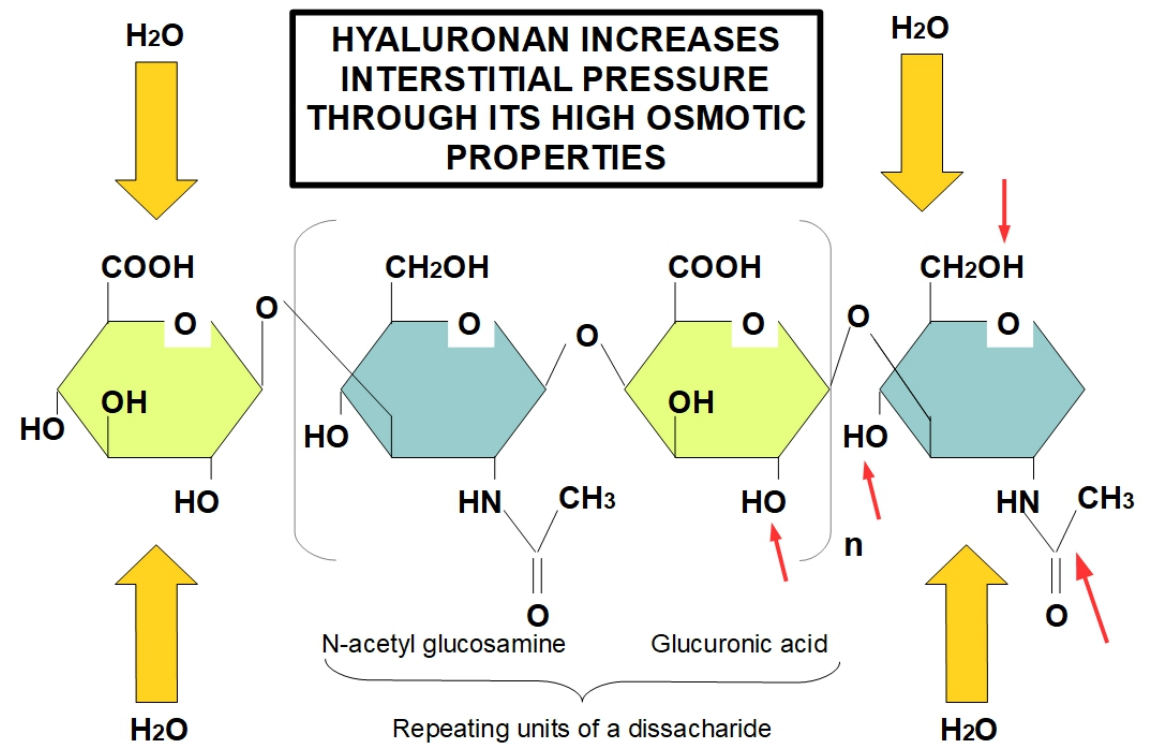
Figure 1. Role of hyaluronan in increasing tissue interstitial pressure. Hyaluronan forms long chains creating a highly osmotic environment that produces edema and increased interstitial pressure. Despite the fact that the diagram only shows a tetrasacharide, hyaluronan is a very lengthy unbranched chain of repeating disaccharides. Red arrows indicate the hydrophilic parts of glucuronic acid and N-acetyl glucosamine, proving the highly hydrophilic ability of hyaluronan. Increased hyaluronan in tumors is an early event occurring in TME, which leads to increased interstitial pressure due to its hygroscopic properties, causing an obstacle to the adequate delivery of chemotherapeutic drugs.